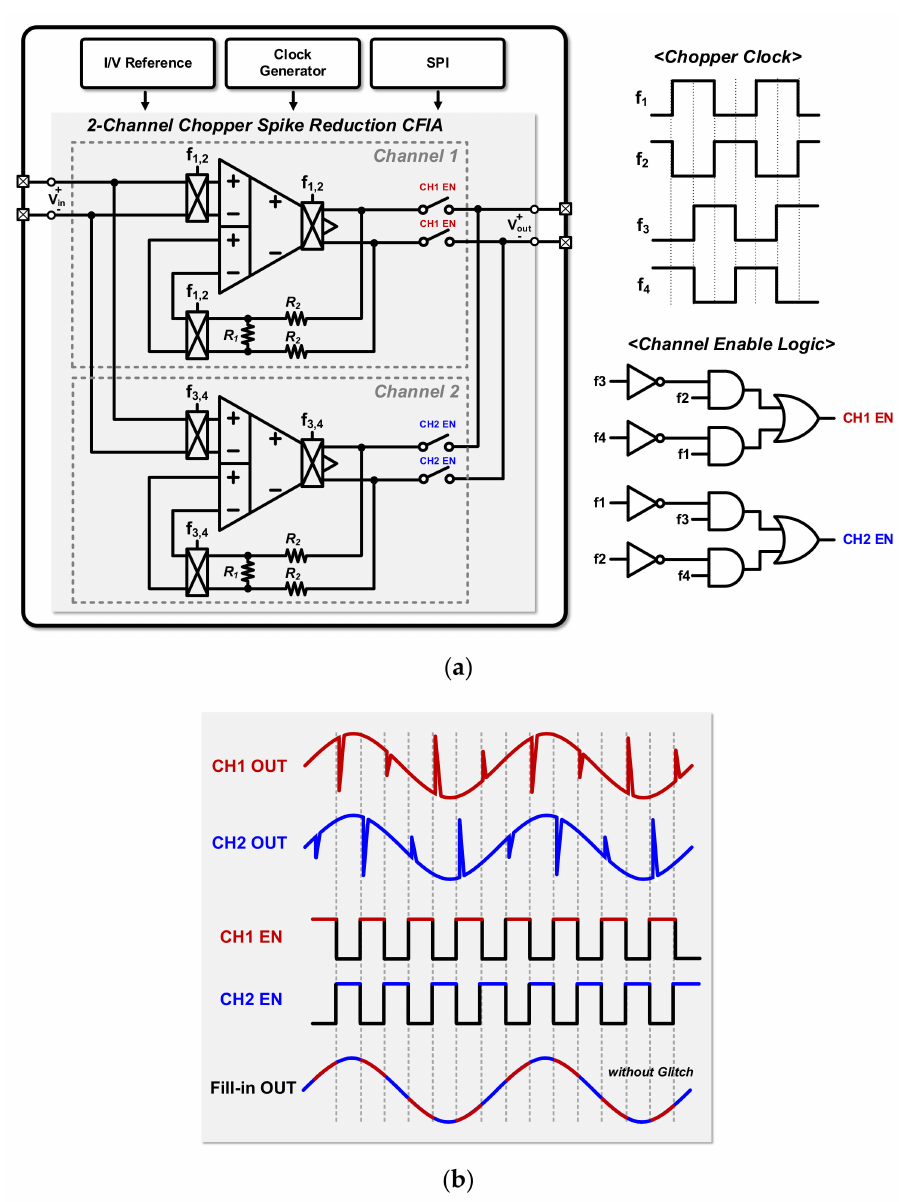
Figure 5. ( a ) The top architecture of the proposed CFIA and ( b ) fill-in